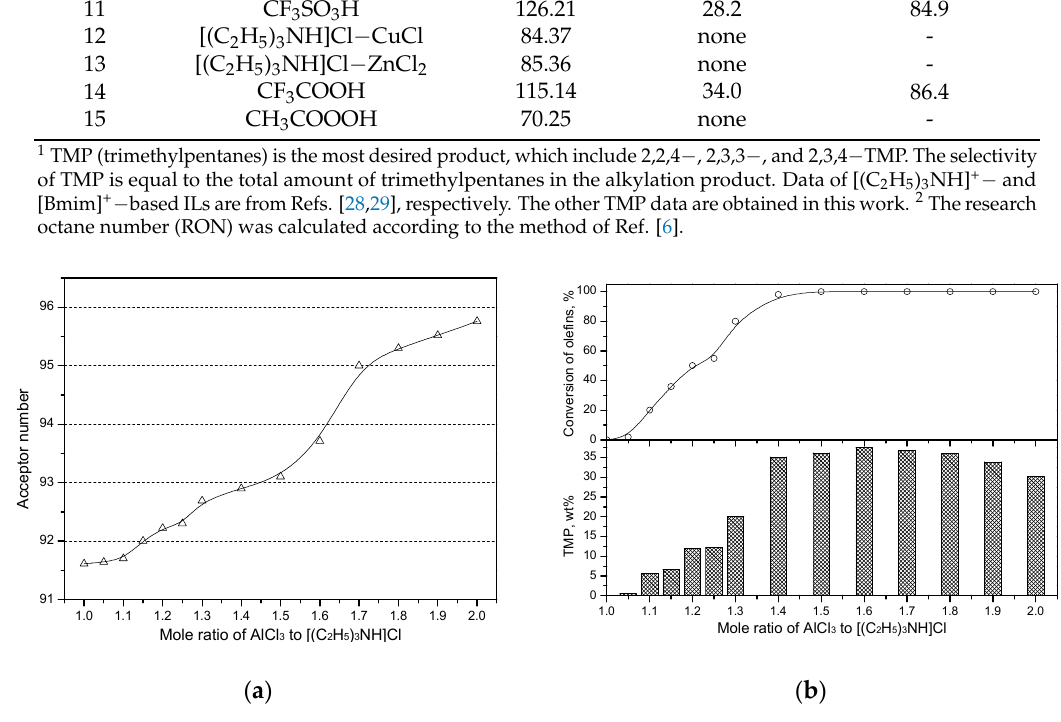
Figure 2. The effects of Lewis acidity on acceptor number, TMP selectivity, and conversion of olefins: ( a ) Mole ratio of AlCl 3 to [(C 2 H 5 ) 3 NH]Cl vs. acceptor number; ( b ) Mole ratio of AlCl 3 to [(C 2 H 5 ) 3 NH]Cl vs. TMP selectivity and conversion of olefins.